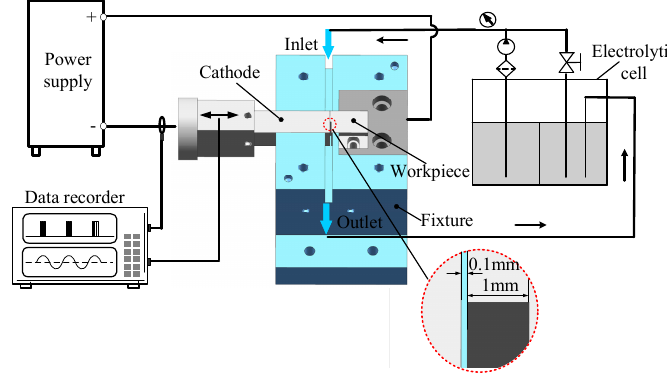
Figure 8. Schematic diagram of the experimental setup.